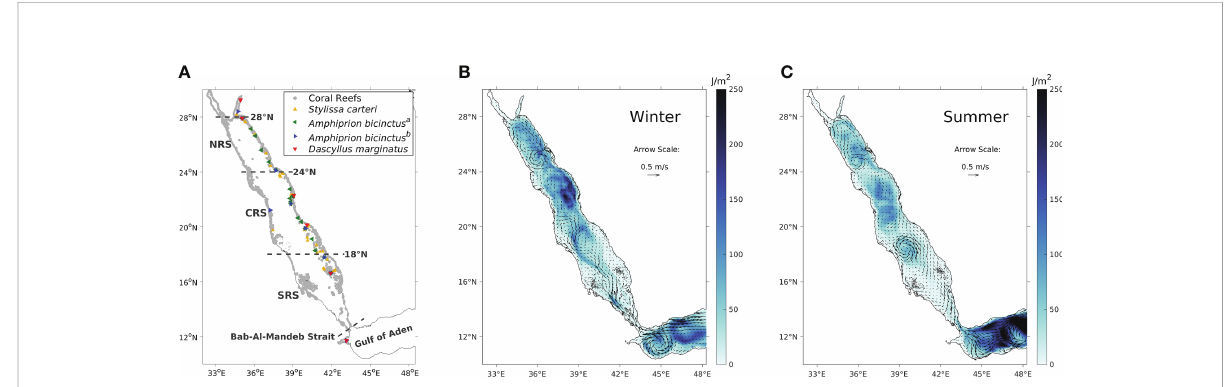
FIGURE 1 (A) Geographic distribution of the Red Sea coral reefs (grey points) and the sampling sites for the four genetic datasets of the reef sponge S. carteri and the reef fi sh A. bicinctusa, A. bicinctusb and D. marginatus . Note that the datasets for Amphiprion bicinctus were obtained from two studies with different sampling sites, and are denoted a and b , respectively. (B) Winter surface currents averaged over the 14 years from 2002 to 2015 (indicated by the arrows) and winter surface eddy kinetic energy (indicated by the colours) which re fl ects the intensity of eddy activities (Zhan et al., 2016). (C) is the same as (B) but showing summer features instead. January and July were chosen to represent the winter and summer seasons, respectively,to maintain consistency with Figure